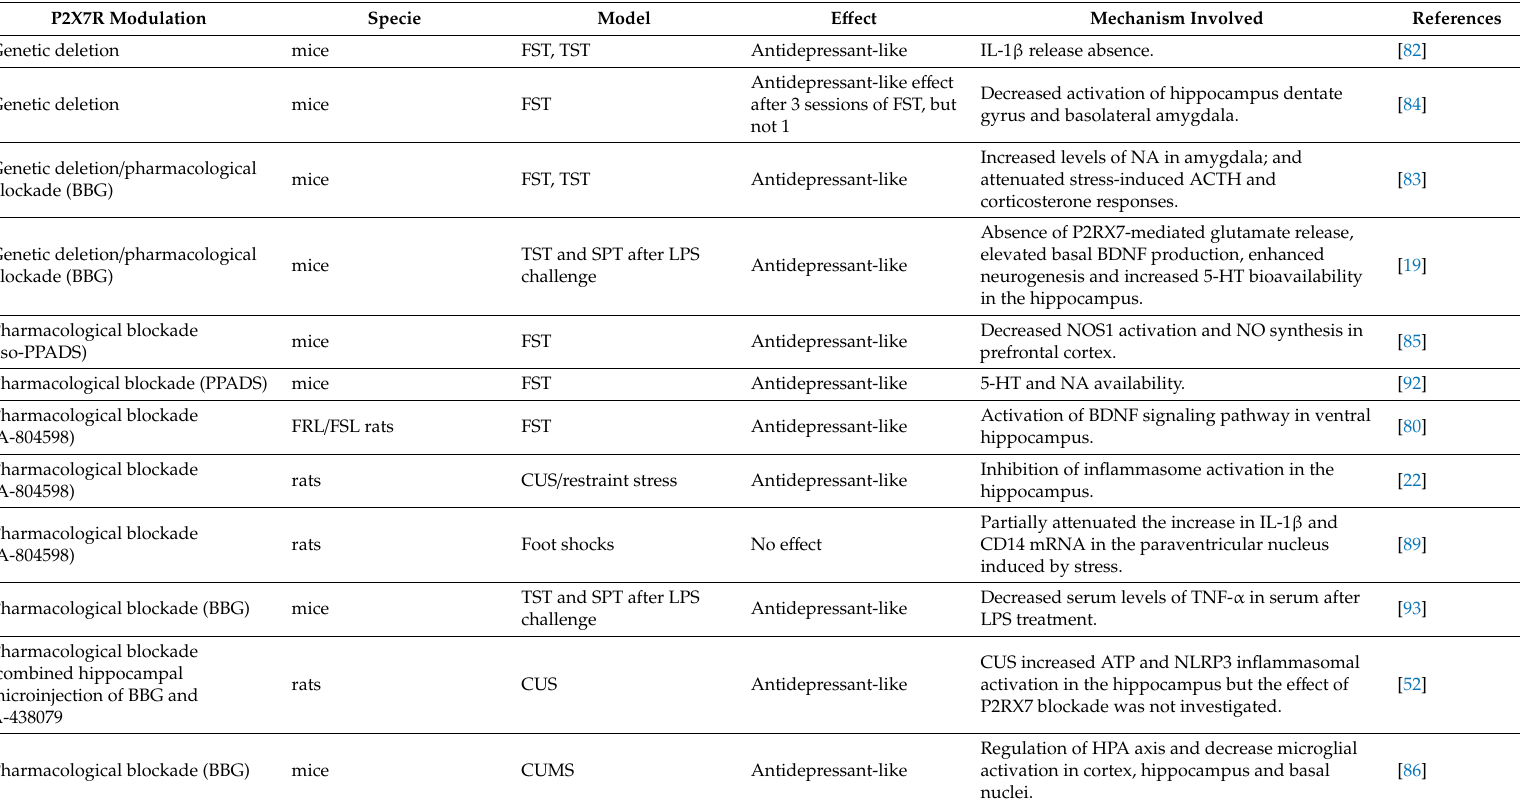
Table 2. E ff ect of P2X7R inhibition in animal models of